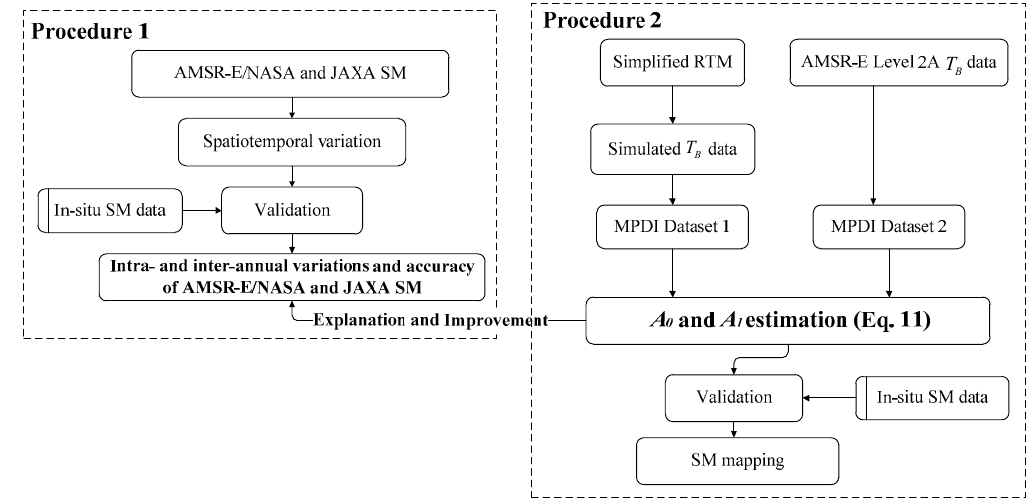
Figure 4. Flow chart of AMSR-E/NASA, JAXA SM product analysis and improving the AMSR-E SM product.